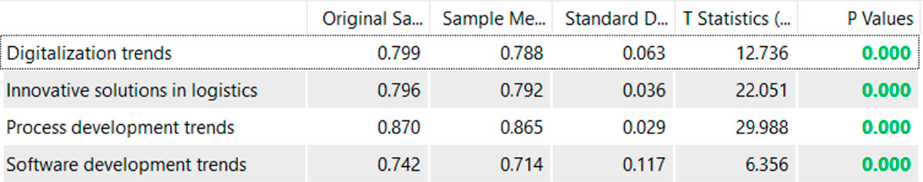
Figure 1. Quality criteria: Cronbach’s Alpha of the model.